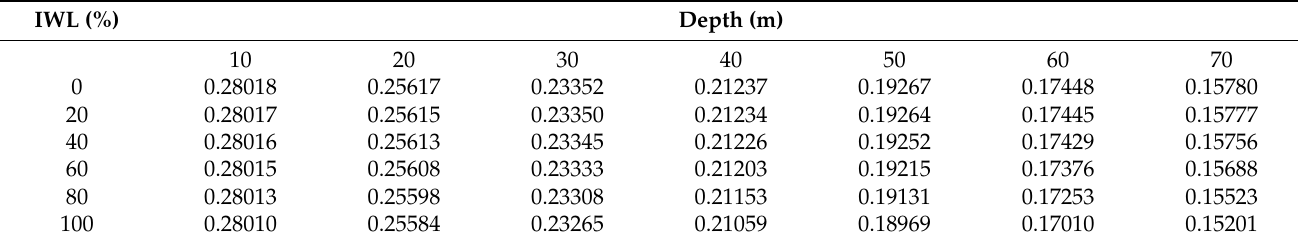
Table 8. Results of natural frequency analysis for first side-to-side mode.